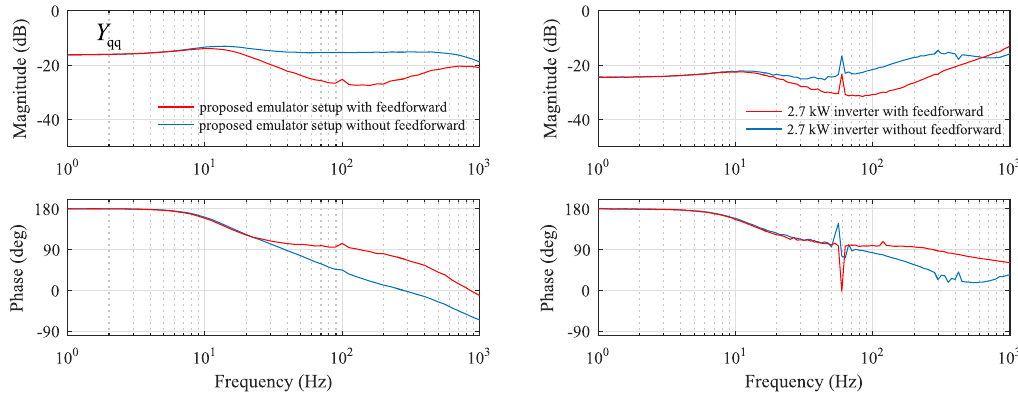
Figure 18. Admittance q-component with and without the grid voltage feedforward: from the proposed emulator ( left ); and from PV inverter prototype ( right